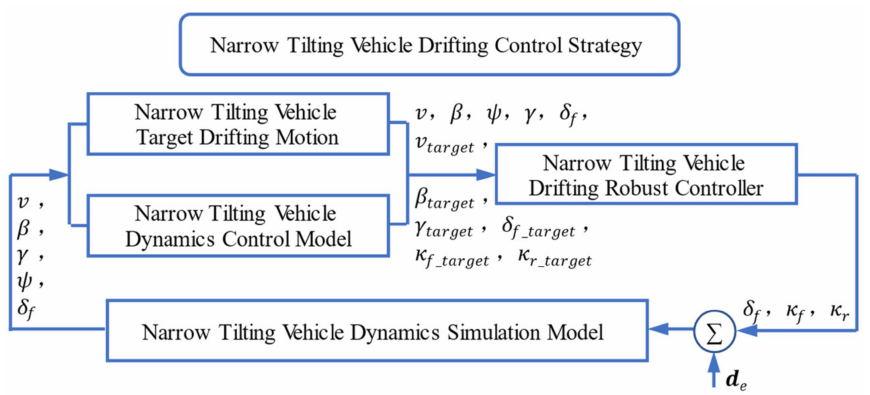
Figure 6. Narrow tilting vehicle drifting control